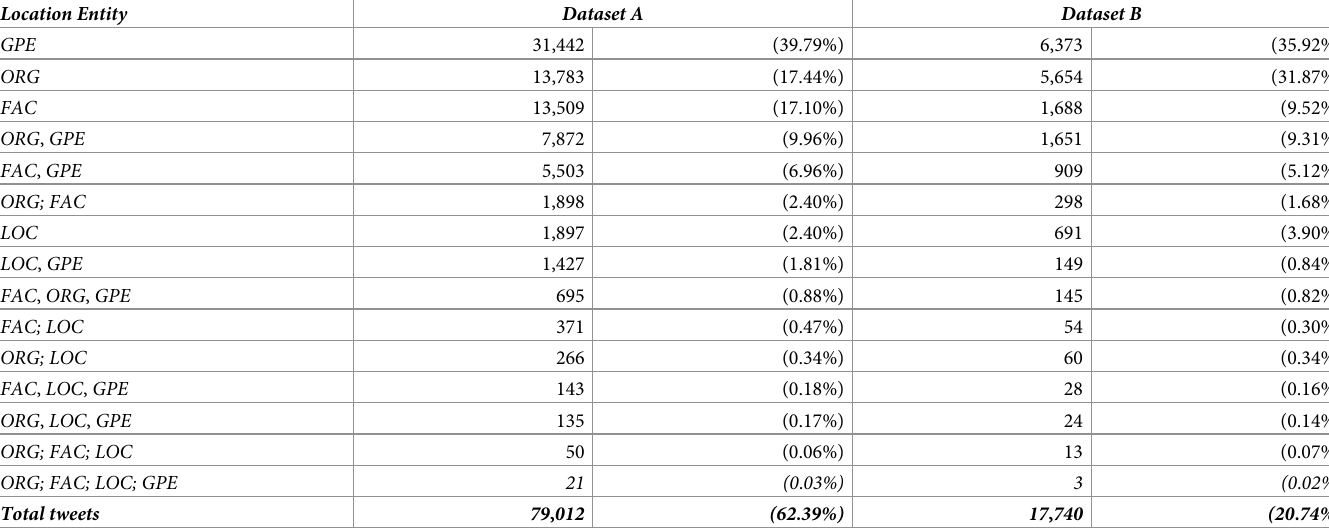
Table 4. Mutually exclusive count of tweets with a location entity extracted in Dataset A and Dataset B. The percentages of each location entity are computed as a frac- tion of the total tweets whilst the percentage of the total tweets is computed as a fraction of the remaining pre-processed posts, for each dataset. The table is sorted by descending order of number of extracted locations in Dataset